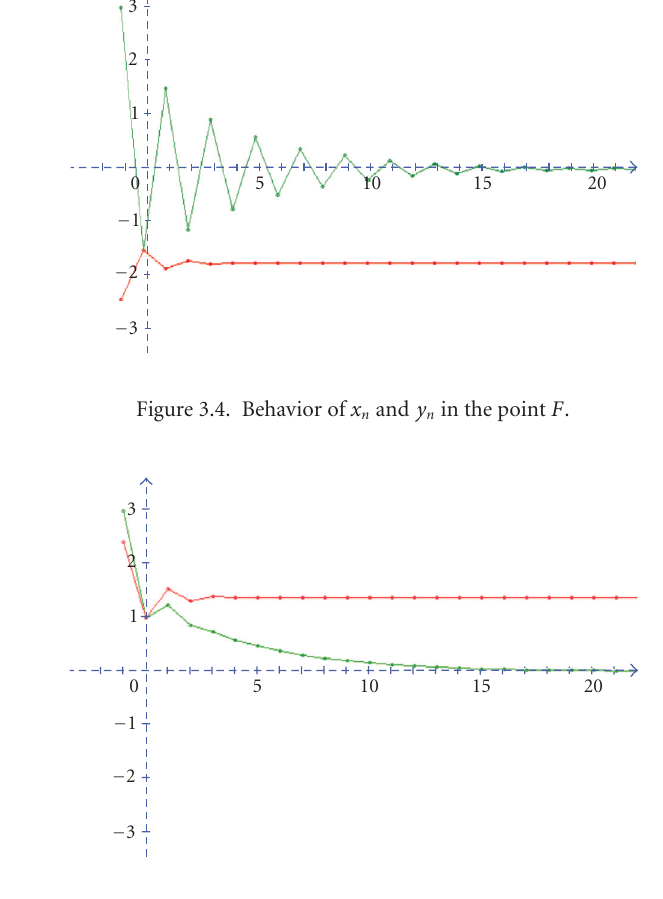
Figure 3.5. Behavior of x n and y n in the point G